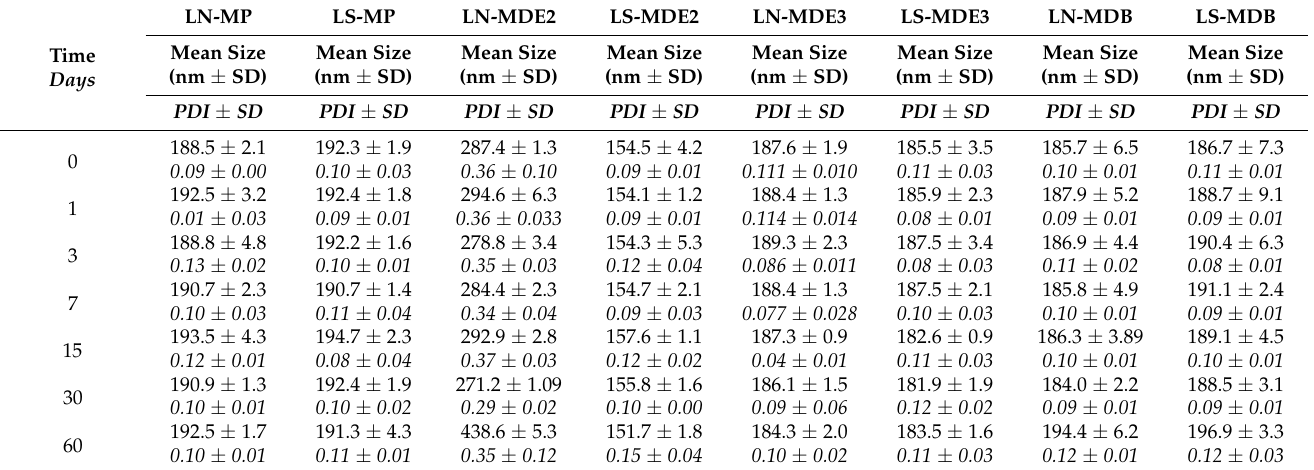
Table 3. Dimensional parameters of extruded liposomes containing manganese complexes in